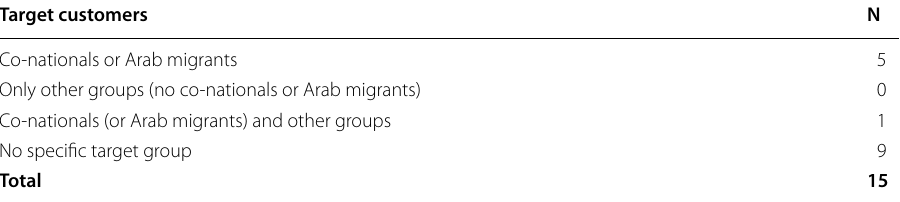
Table 2 Target customers Target customers N Co-nationals or Arab migrants Only other groups (no co-nationals or Arab migrants) Co-nationals (or Arab migrants) and other